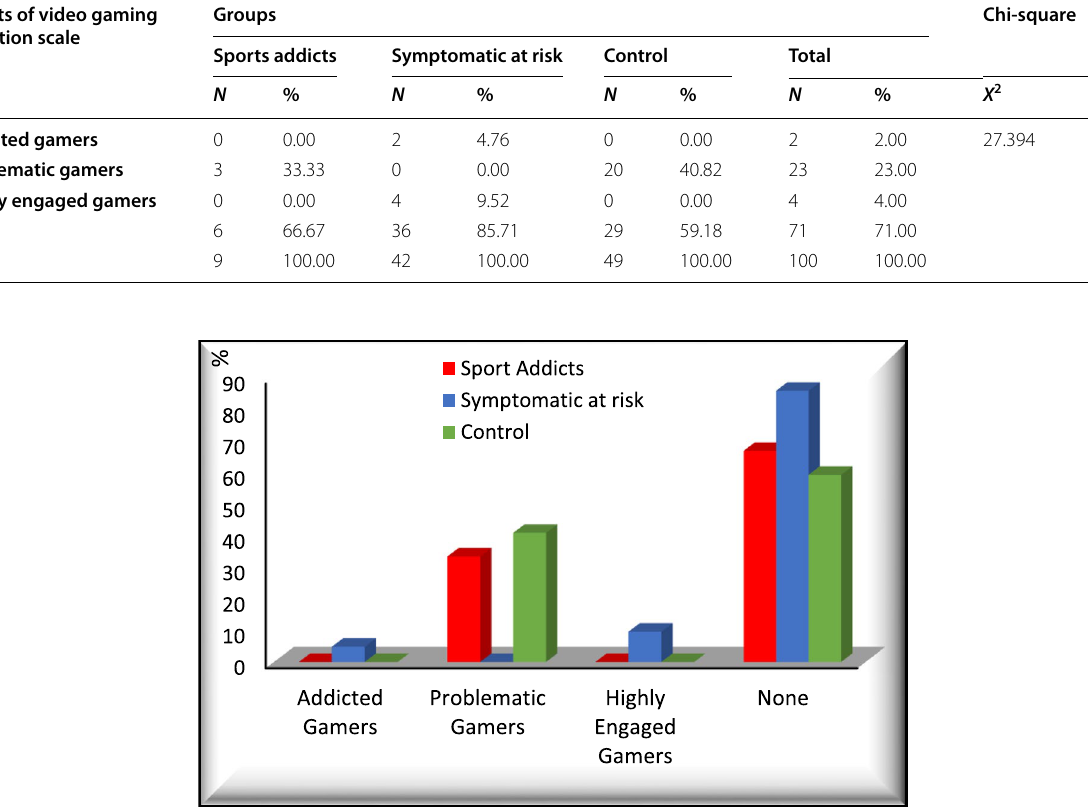
Fig. 2 Video Gaming Addiction Scale among sports addicts and control